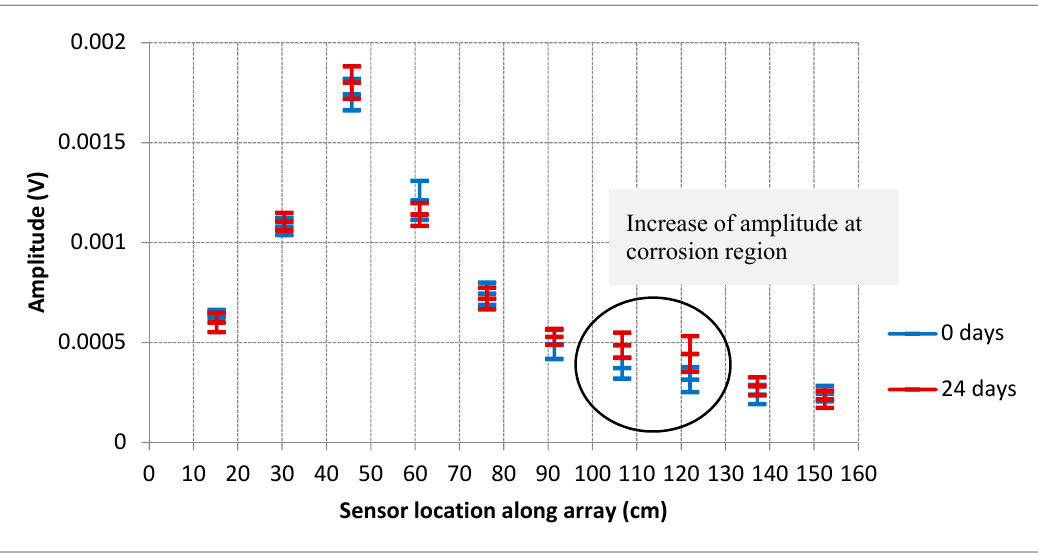
Figure 10. Amplitude of leaked waves versus sensor location plot for Specimen 1, with the transmitter on the corroded bar (Rebar 1) and receivers 91.44 cm (3 ft.) away from the bar (note that the vertical scale of this plot is 2/7 or 28% that of the plot in Figure 9).